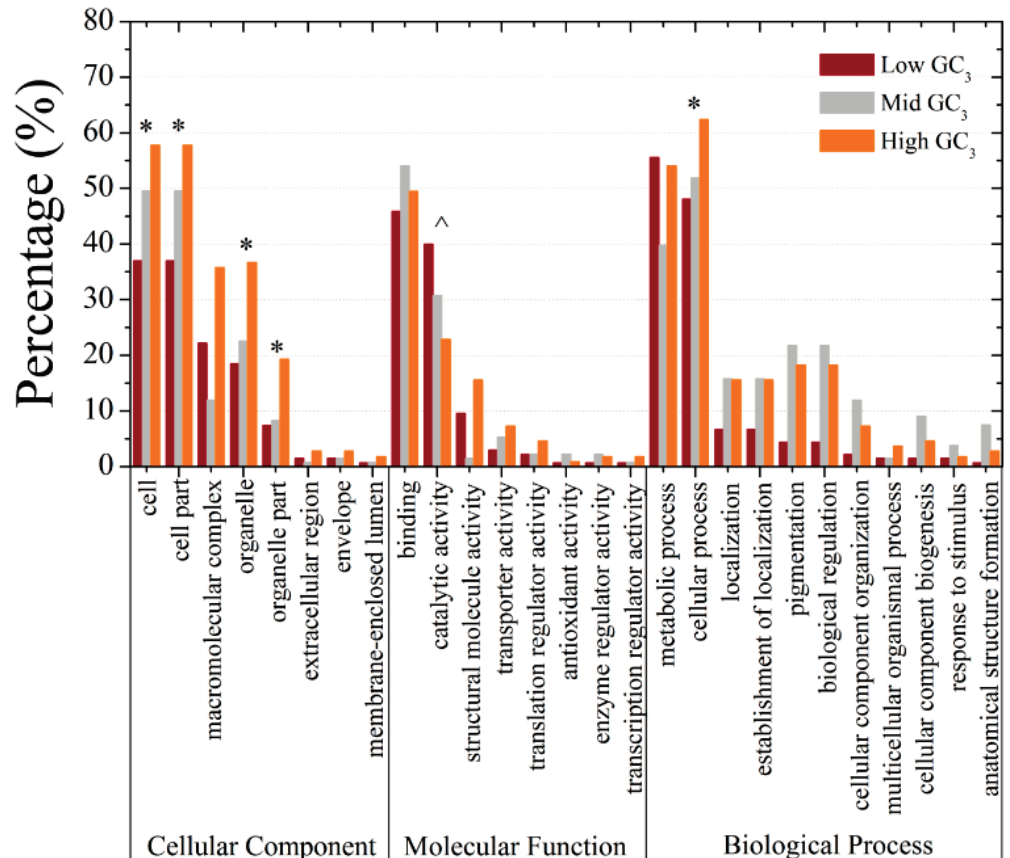
Figure 6. Gene ontology (GO) classifications for three GC 3 levels in M. amblycephala . * indicates, in a particular GO category at the 5% level, a significantly higher percentage of genes in high GC 3 groups than low GC 3 groups, while the percentage of mid GC 3 groups is intermediate; ^ represents an opposite